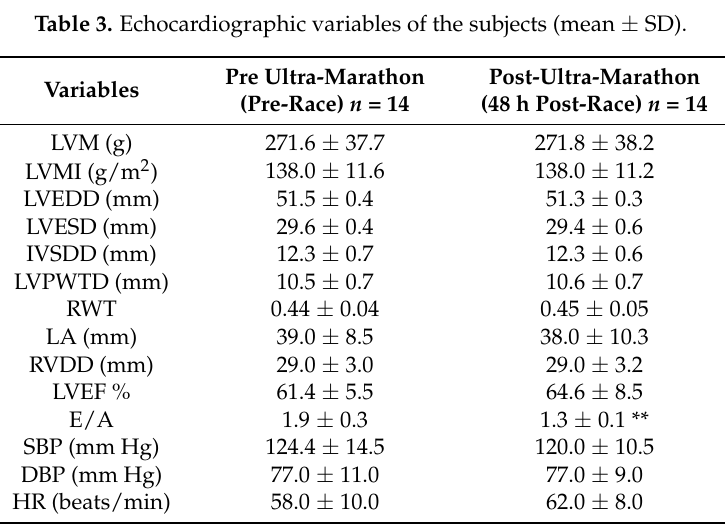
Table 3. Echocardiographic variables of the subjects (mean ±